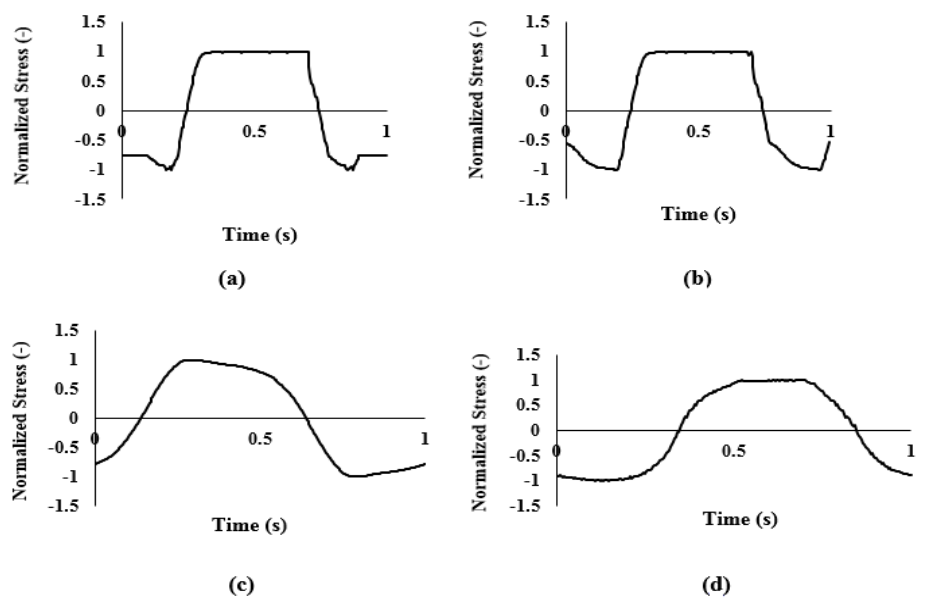
Figure 4. Normalized stress signal as a function of time for the SBL-extract-added Feta-cheese samples at 3rd day ( a ), 20th day ( b ), 40th day ( c ), and 60th day ( d ) in n-LVE region (1 Hz and 1000% strain). Table 6. The third harmonic viscoelastic modulus to the first harmonic viscoelastic modulus ( G (cid:48) and G (cid:48)(cid:48) / G (cid:48)(cid:48) ), strain-hardening ratio (S) and shear-thickening ratio (T) of SBL-extract-added cheese 3 1 samples at different storage